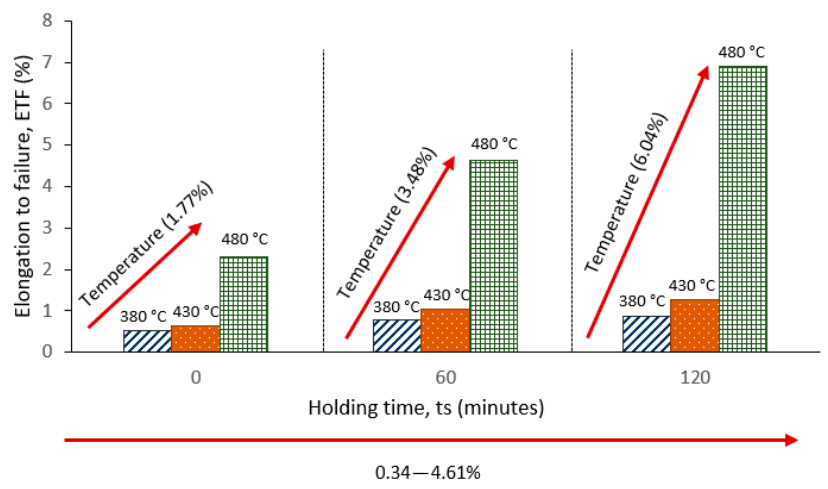
Figure 5. Elongation to failure results at different working temperatures and duration.